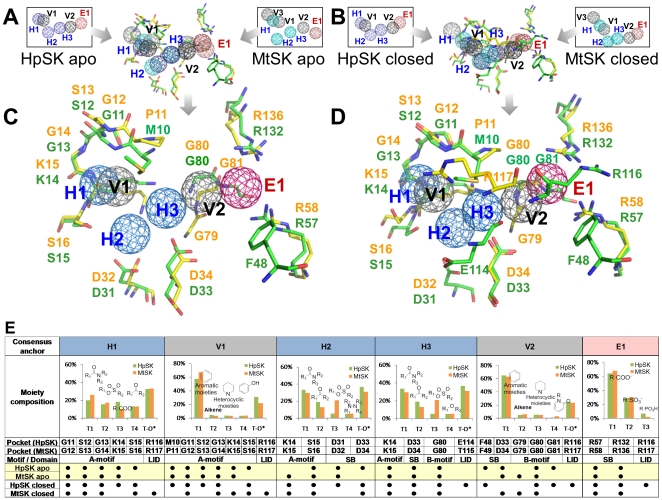
Shikimate kinase CoreSiMMaps.(A) Superimposed apo-form anchors of HpSK and MtSK. (B) Superimposed closed-form anchors of HpSK and MtSK. (C) The apo-form CoreSiMMap and (D) the closed-form CoreSiMMap include six consensus anchors derived from consensus anchors (A) and (B), respectively. Each consensus anchor shares conserved residues between HpSK and MtSK and has the same interaction type of binding environment. (E) Features of the six consensus anchors of the apo-form CoreSiMMap. Each of the T groups (T1–T4) represents a given chemical moiety and T-O* indicates other chemical groups. H1, V1, and H2 are situated at the ATP-binding site, while H3, V2, and E1 are at the shikimate-binding site. Each consensus anchor includes conserved interacting residues (•) and the major chemical moieties of the compound candidates.